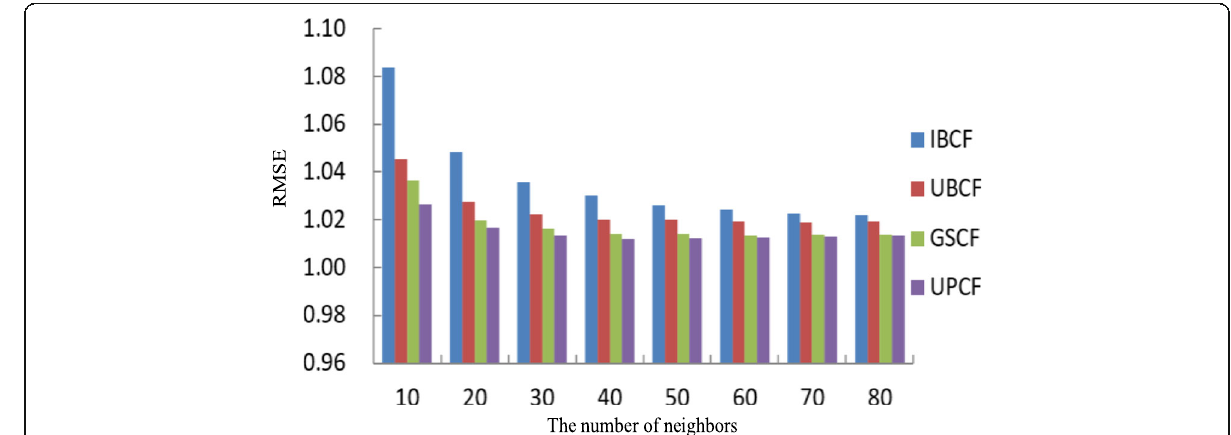
Fig. 7 The comparison of RMSE values between four algorithms in train2. With the increase in the number of nearest neighbors, the value of RMSE decreased first and then increased. When the nearest neighbor number is about 40, the value of RMSE is the smallest. In the case of the same number of near neighbors, the RMSE value of the UPCF algorithm is the smallest, that is, the error between the real score and the prediction score is the smallest, and the performance is the